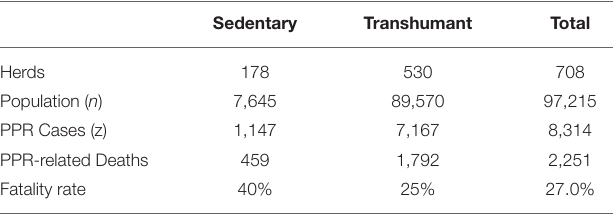
TABLE 3 | Summary table of disease impact survey by type of